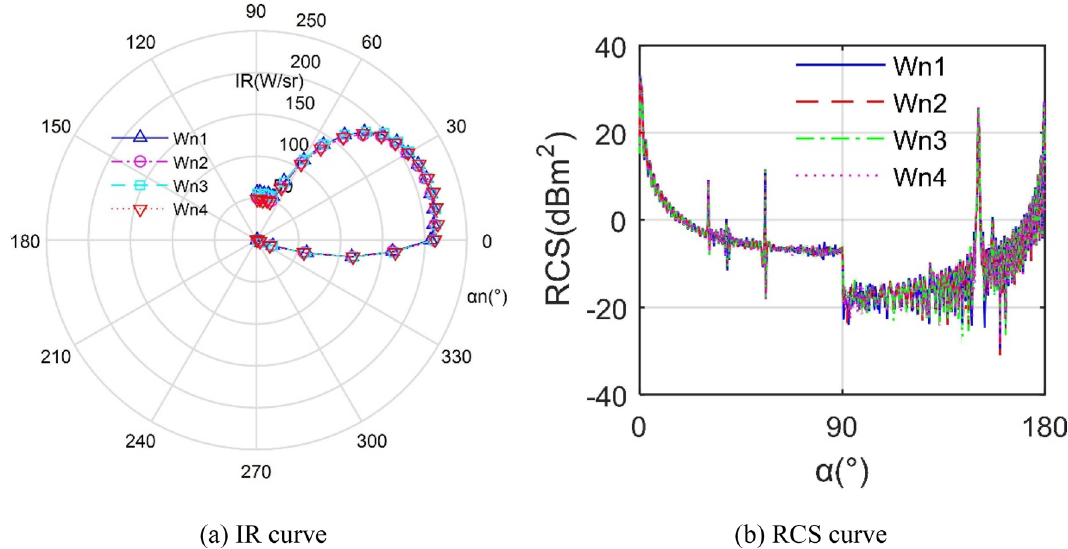
Figure 14. Comparison of stealth characteristics of aircraft under different W n